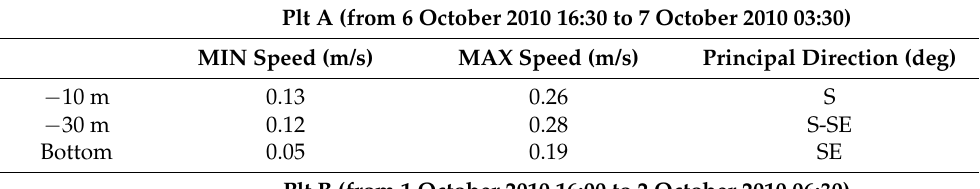
Table 8. Current intensity and direction during the discharge event shown in Figures 16 and 17.